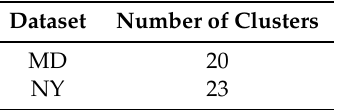
Table 6. Number of automatically detected fuzzy clusters.